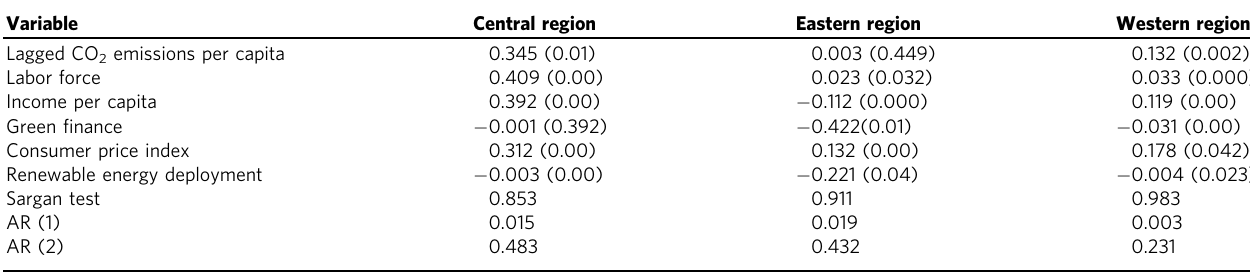
Table 5 System GMM estimations for three regions of China.